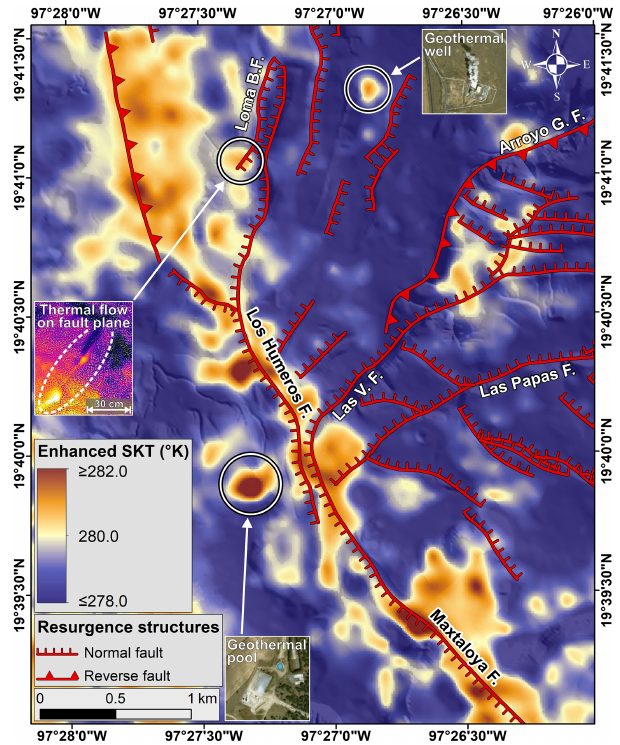
Figure 3. Enhanced surface kinetic temperature (SKT) of the Los Potreros caldera obtained from Advanced Spaceborne Thermal Emission and Reflection Radiometer (ASTER) AST_08 nighttime thermal remote sensing data (see Norini et al., 2015, for details on methods and results). Examples of field-validated sources of ther- mal anomalies are shown in the insets (Norini et al., 2015, 2019). Thermal satellite data: credits LP DAAC, USGS EROS data centre at NASA. Satellite images in the insets: credits Esri, DigitalGlobe,